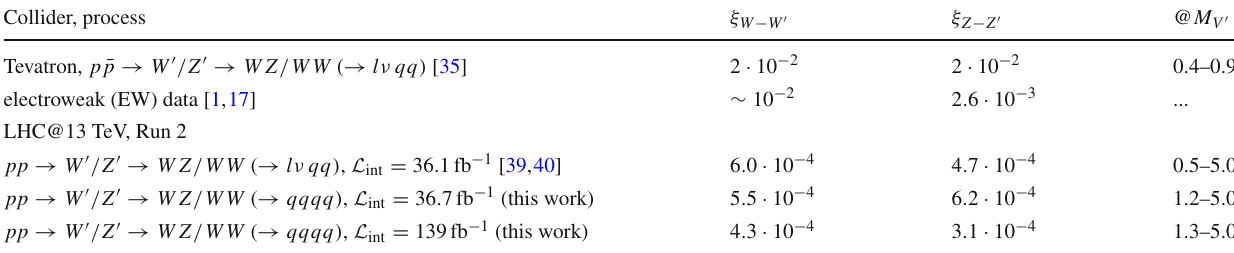
Table 3 Upper limits on mixing parameters ξ W − W (cid:2) and ξ Z − Z (cid:2) at 95% CL in the EGM, processes and experiments Collider, process ξ W − W (cid:2) ξ Z − Z (cid:2) @ M V (cid:2) Tevatron, p ¯ p → W (cid:2) / Z (cid:2) → W Z / WW ( → l ν qq )